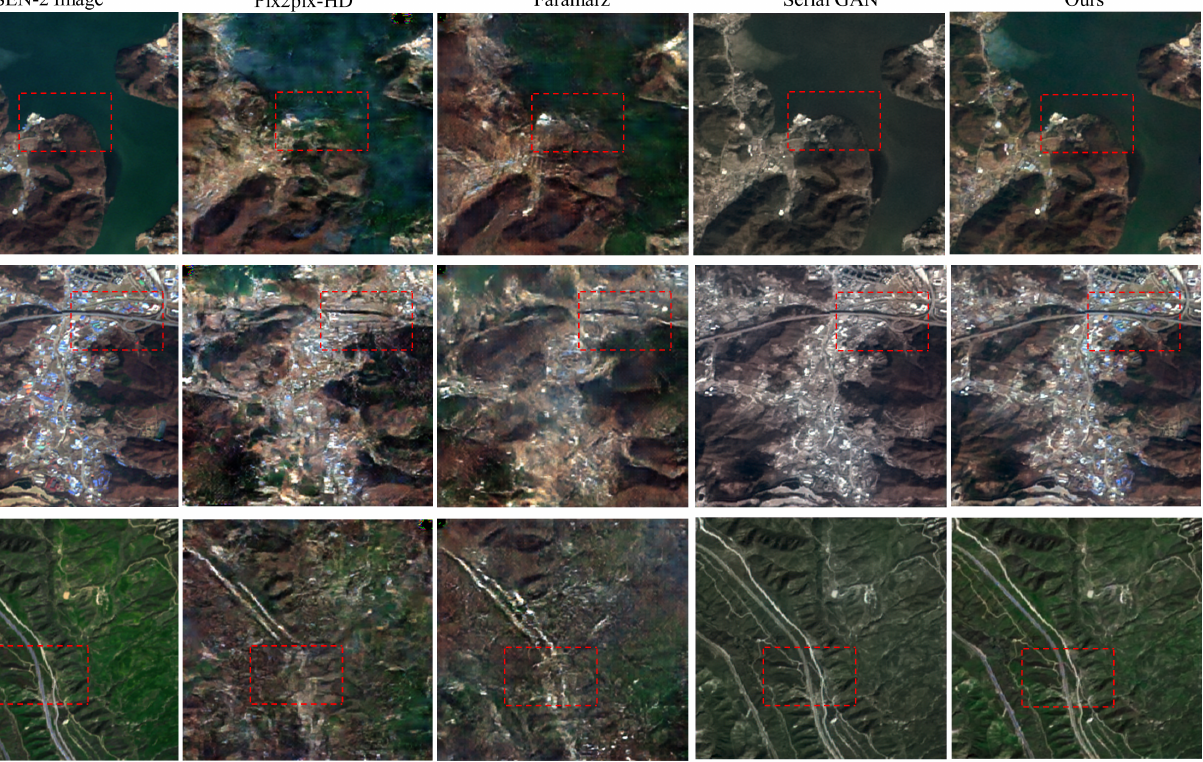
Figure 9. The local detail comparison of different SAR-to-optical transformation models, some noteworthy local areas in three different scenarios are circled in red boxes. The columns from left to right show Optical images, results of Pix2pix-HD, results of Faramarz et al. model, results of Serial GAN, and our results, respectively. Best viewed in